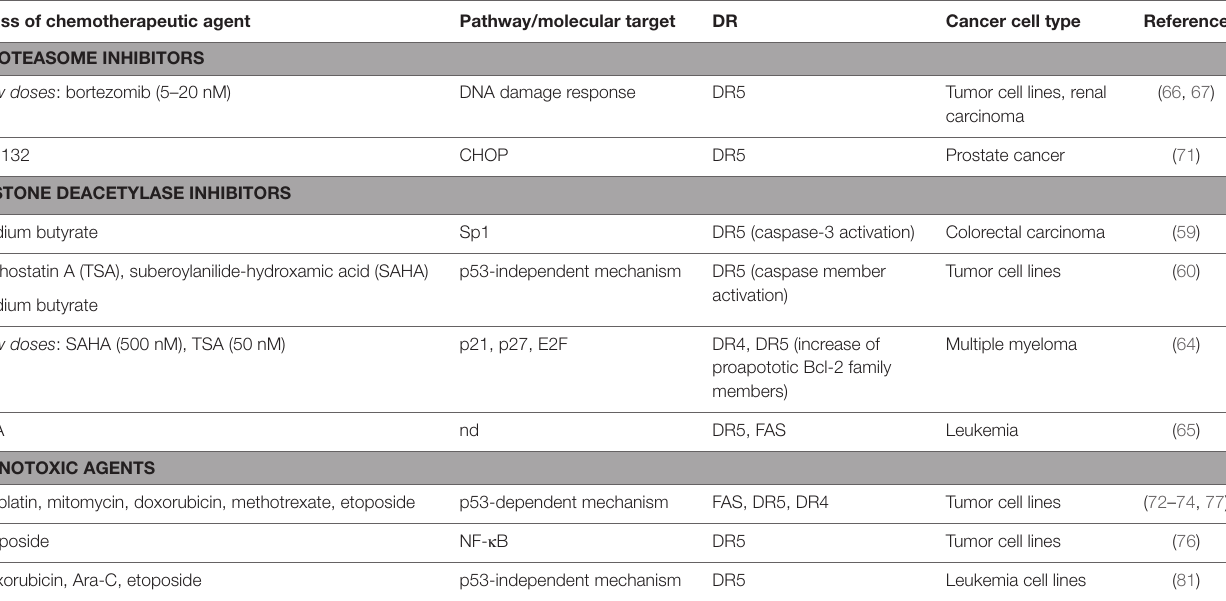
TABLe 2 | Chemotherapy-induced pathways and molecular targets able to modulate death receptors (DRs) on cancer